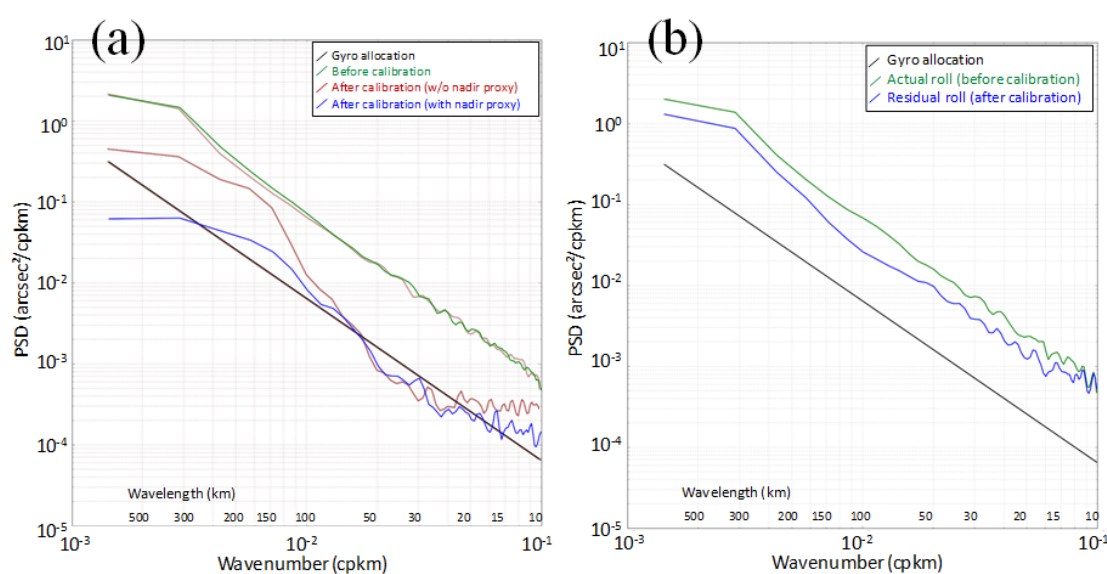
Figure 12. Average performance of the direct method ( a ) and the collinear method ( b